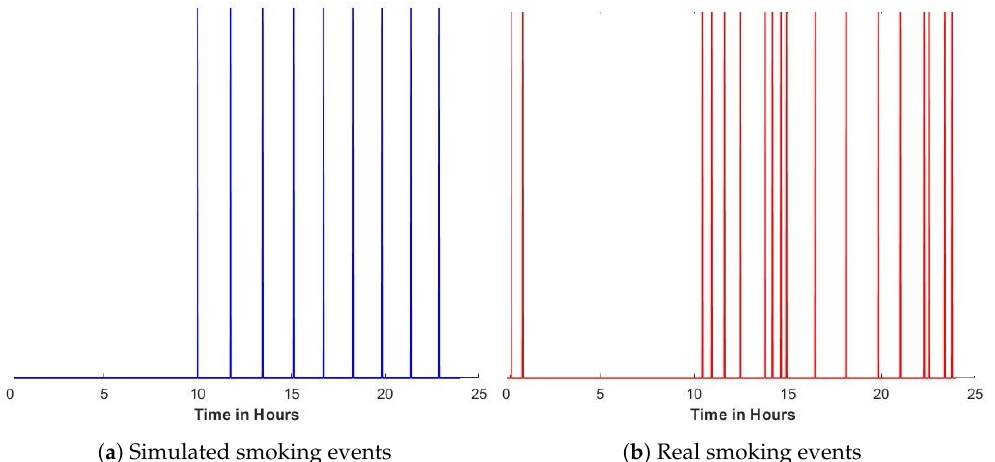
Figure 2. Smoking frequency; each peak represents a smoking event using smoking events reported from a randomly-selected day from our collected data of one of our participants [2]. ( a ) a simulated smoking behaviour generated by the control theory model [16] , and ( b ) real smoking